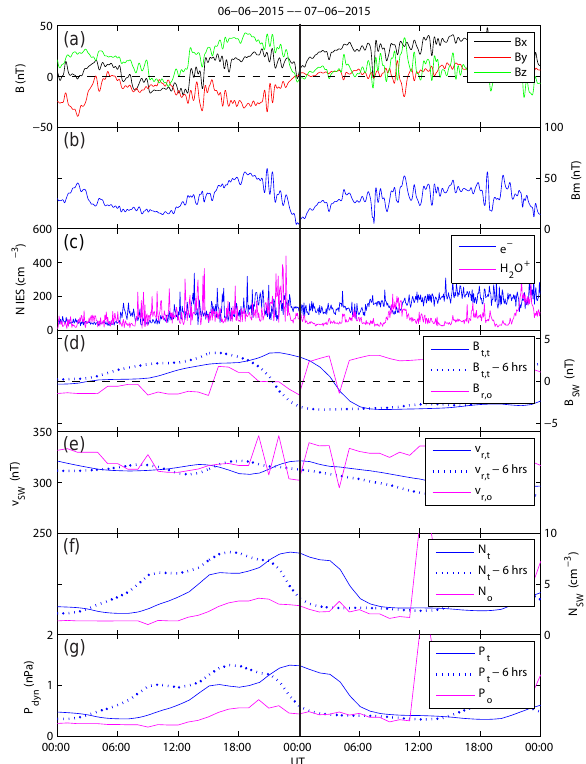
Figure 4. (a) The magnetic field in CESQ coordinates. (b) The magnitude of the magnetic field. (c) The electron and ion velocities deduced from IES. (d) The propagated solar wind magnetic field in cylindrical coordinates. (e) The propagated solar wind velocity in cylindrical coordinates. (f) The propagated solar wind